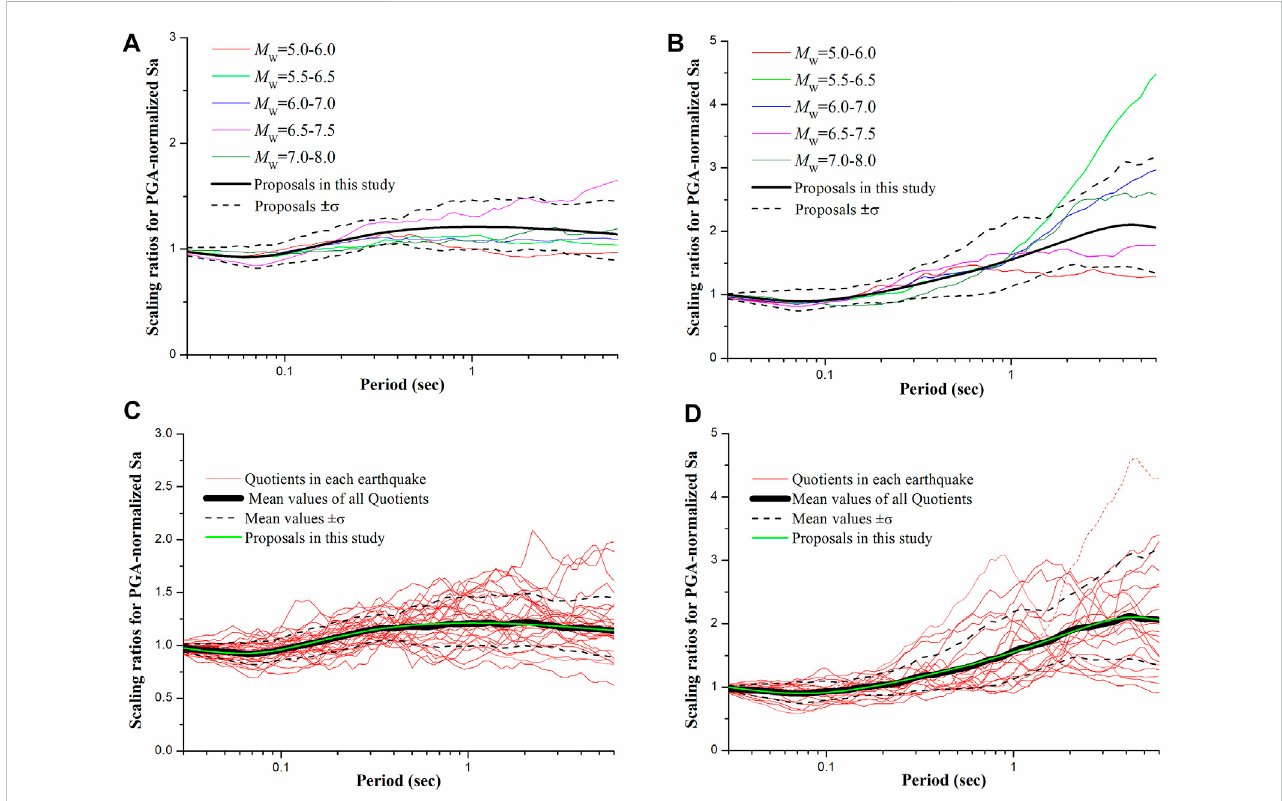
FIGURE 6 Quotients of PGA-normalized Sa on (A) site class II, (B) site class III divided by PGA-normalized Sa on site class I with different moment magnitude intervals,andquotients ofPGA-normalizedSaon (C) siteclassII, (D) siteclassIIIdividedbyPGA-normalizedSaonsiteclassIinthesameselectedearthquake. The scaling ratios proposed in this study were shown in green